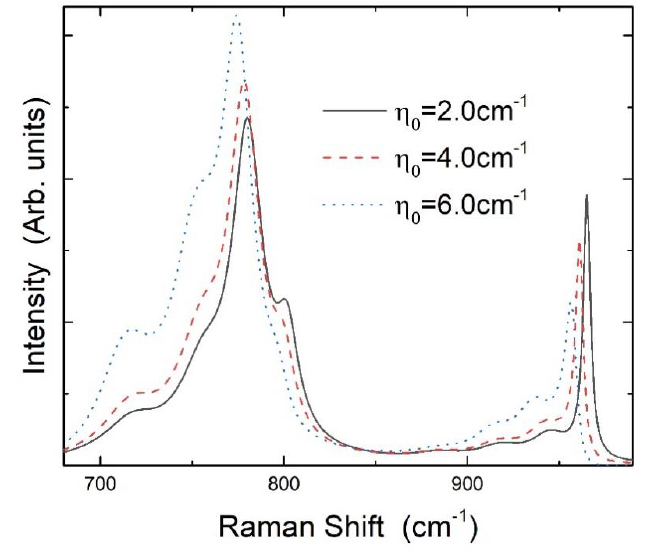
Figure 5. Calculated Raman spectra of the FTO and FLO modes for different values of common coupling strength η 0 . The parameters specifying the difference of the modes in coupling with the plasmons are as follows: q LO = 4.5, q TO = 2.0, λ LO = 0.86, and λ TO = 0.31. The damping rates for the FTO and FLO modes are: Γ l ,1 = 5 cm − 1 , Γ l ,2 = 25 cm − 1 , Γ l ,3 = 30 cm − 1 , Γ l ,4 = 35 cm − 1